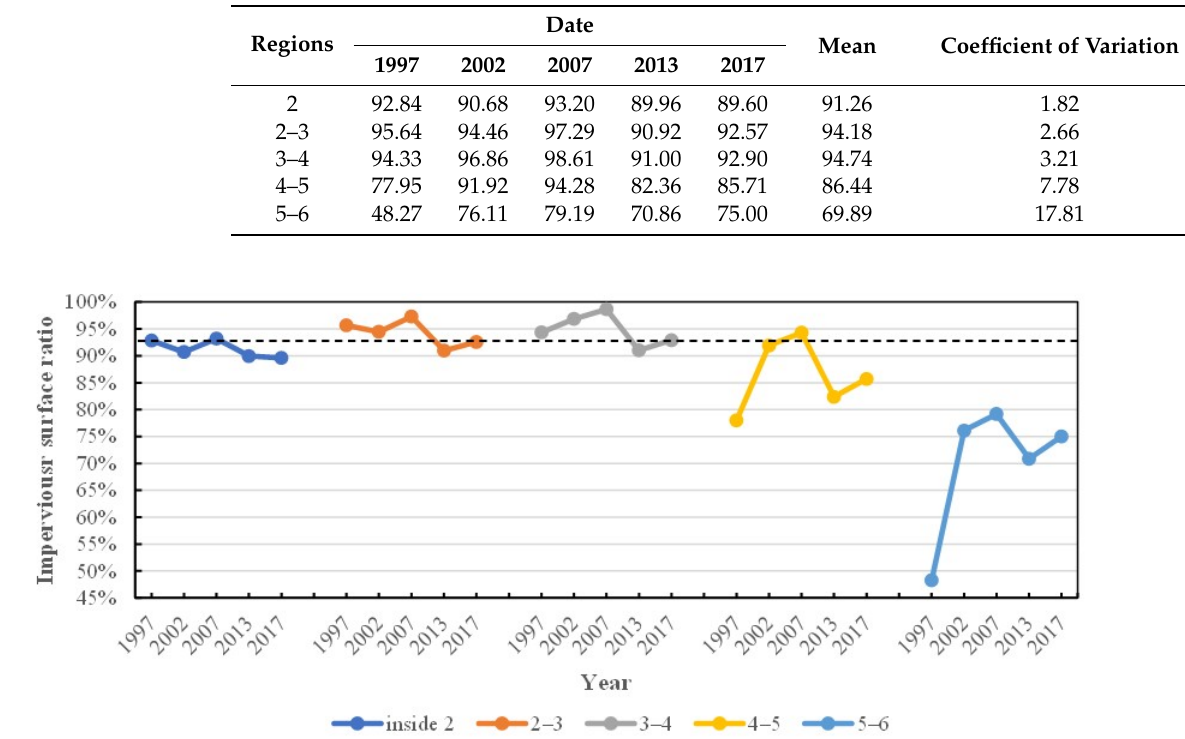
Figure 6. The variation trends of the regional ISRs. The dotted line connects the start point of the ISR inside the second ring road, the endpoint of the ISR between the second and third ring roads, and the endpoint of the ISR between the third and fourth ring roads.